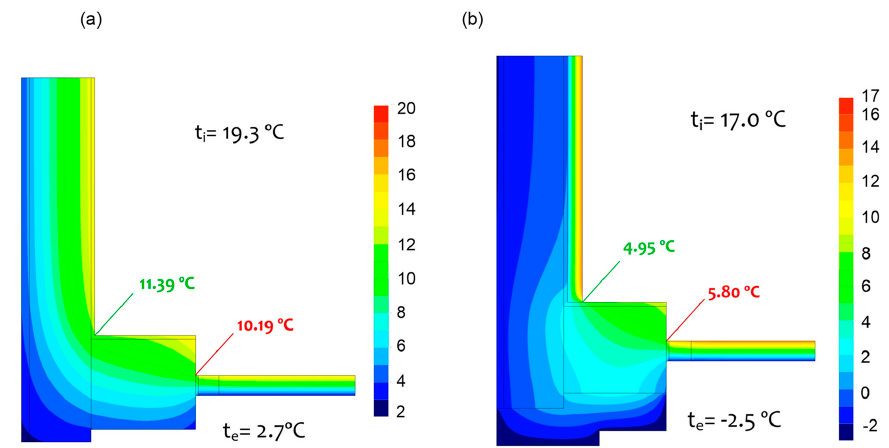
Figure 11. Simulated temperature distribution, of the connection of outer walls: ( a ) simulations without thermal insulation; ( b ) simulations with thermal insulation.